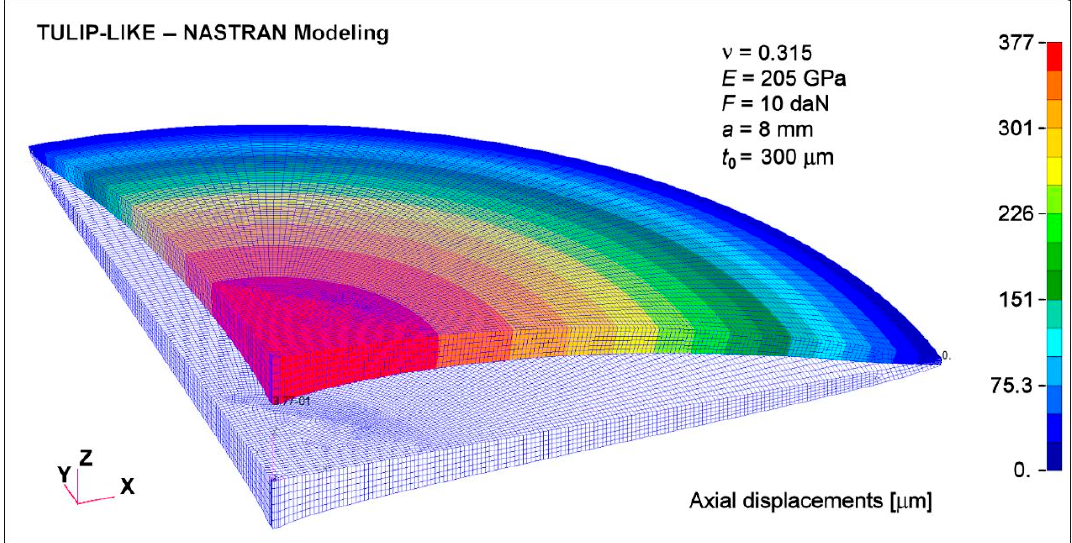
Figure 5. Axial displacements for medium intensity force F = 10 daN. Thickness distribution as before.